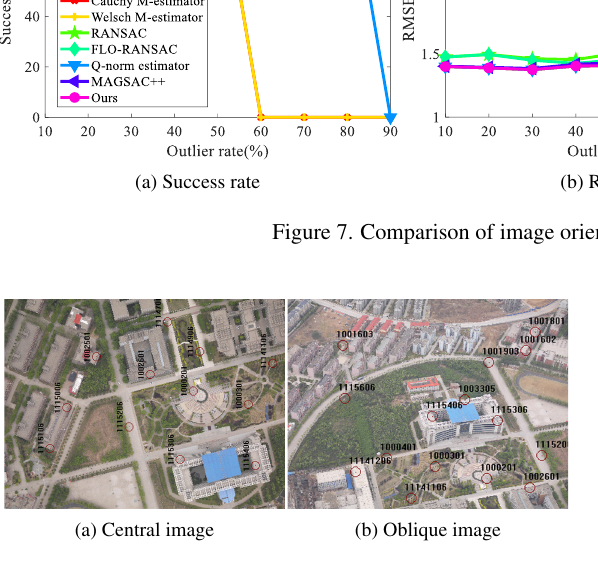
Table 3. The Experimental Results of the Second Image Methods φ /degree